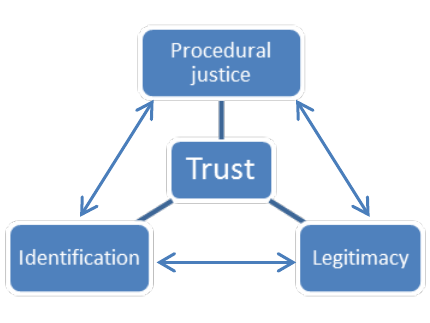
FIGURE 2: THE DRIVERS OF TRUST Source: Author’s